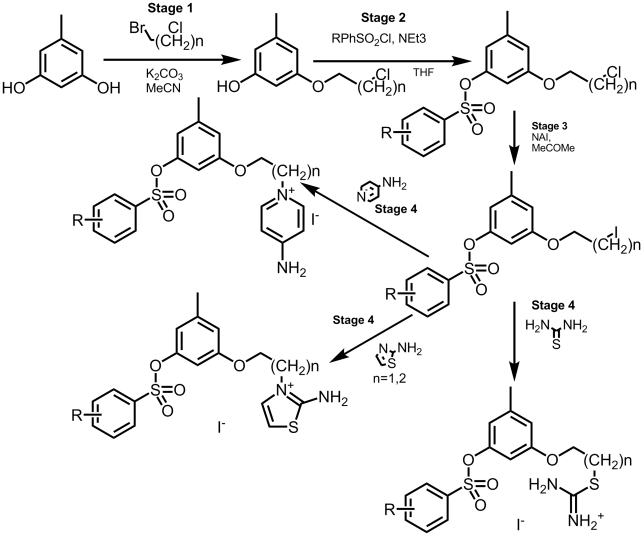
Synthetic scheme of the new orcinol-based thrombin inhibitors.Reagents: (stage 1) BrCH2(CH2)nCl, K2CO3, (CH3)2CO or CH3CN, reflux, 36–43 h; components of reaction mixture were used for subsequent reactions without purification of individual ingredients; (stage 2) RPhSO2Cl, Et3N, THF, stirring, 20–25°C, 7 h or ArSO2Cl, PyH, 20–25°C, 3 days then 60°C, 2 h; (stage 3) NaI, (CH3)2CO or CH3CN, reflux, 48 h; (stage 4) corresponding nucleophile dioxane, 80°C, 2 days or reflux, 20 h.